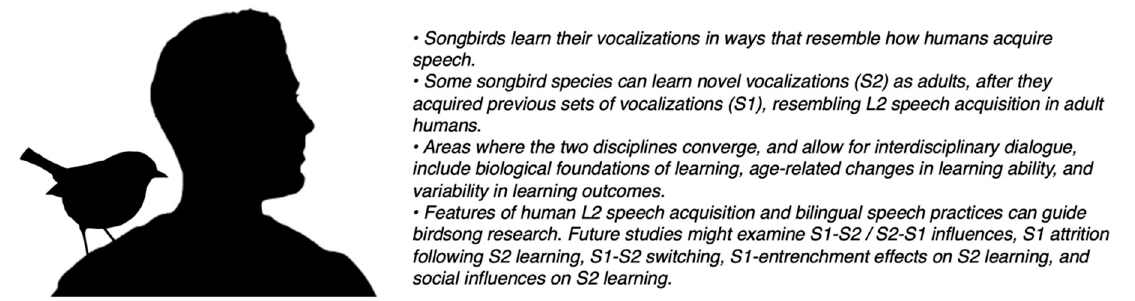
Figure 5. Overview of some main points of the article. (Silhouettes: human; https://pxhere.com/en/photo/1583761 (ac- cessed on 13 December 2021); bird https://pixabay.com/vectors/bird-stand-silhouette-nature-2803709 (accessed on 13 De- cember 2021)).